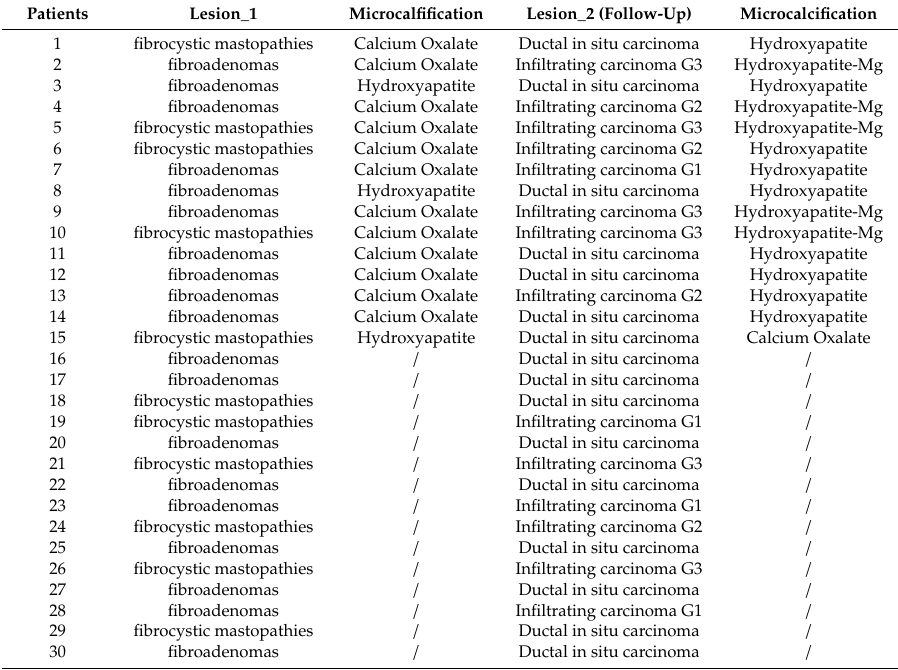
Table 1. List of patients with